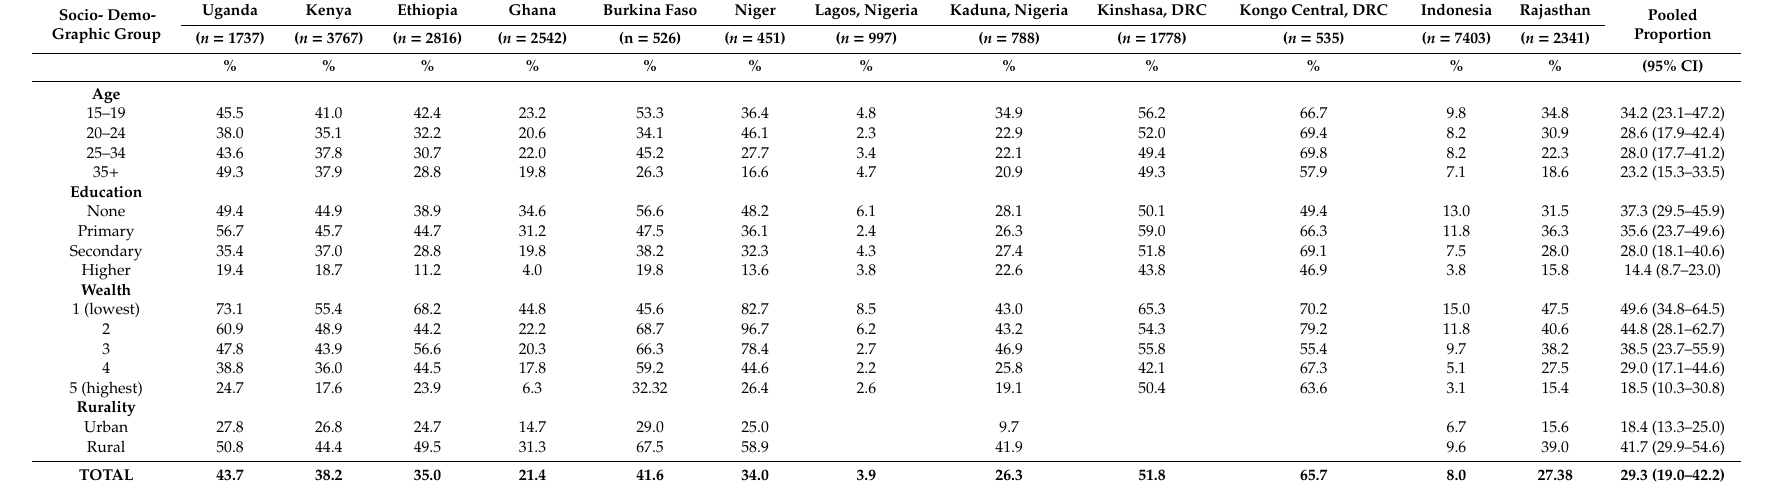
Table 4. Misrepresentation of menstrual needs as being met among those using any menstrual pads (multi-response variable), by socio-demographic characteristics. Socio- Demo- Graphic